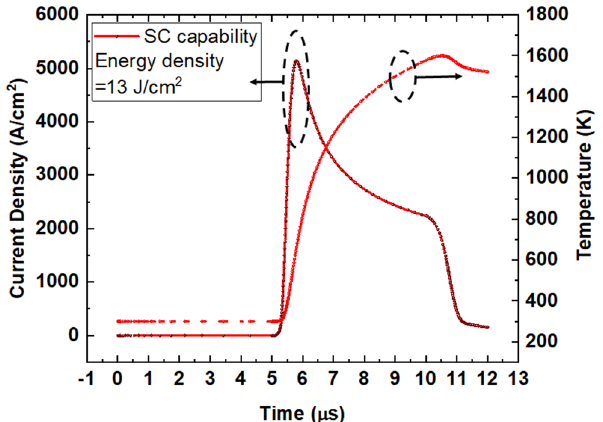
Figure 17. Short circuit simulation result showing current and temperature trend with V ds = 800 V and V gs = 20 V pulse.